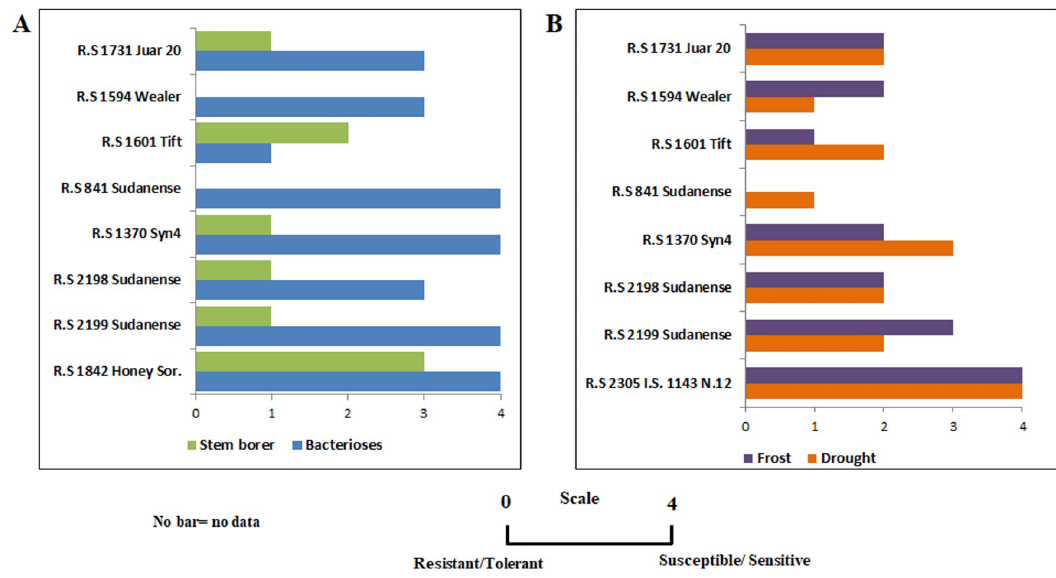
Fig 5. Differential response to biotic and abiotic stresses across sudangrass accessions. (A) Response to stem borer and bacterioses attacks. Accession R . S 1842 Honey Sor . was used as susceptibility control (B) Response to frost and drought. Accession R . S 2305 I . S . 1143 N . 12 was used as susceptibility